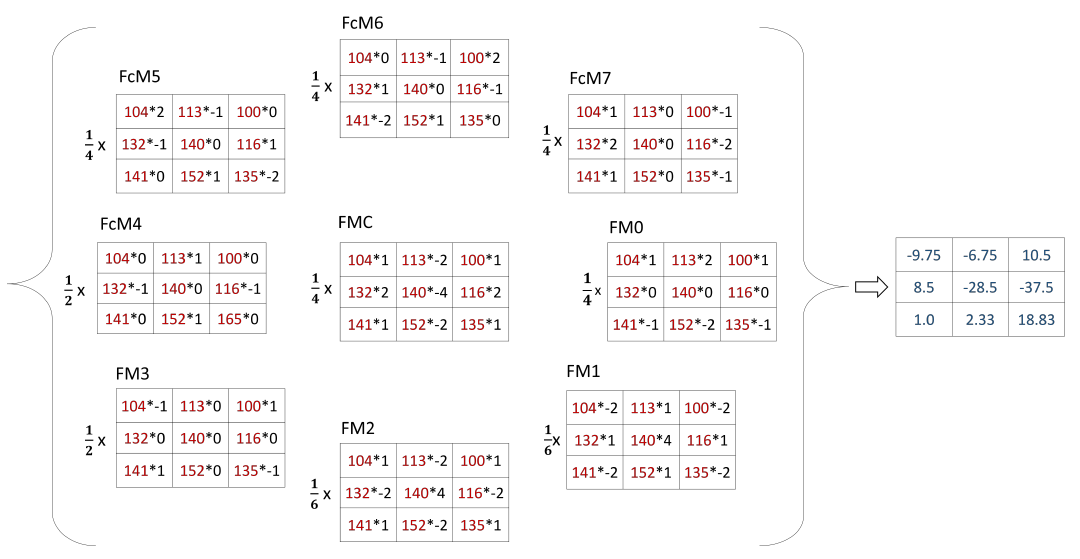
Figure 5. Illustration of local directional ternary pattern